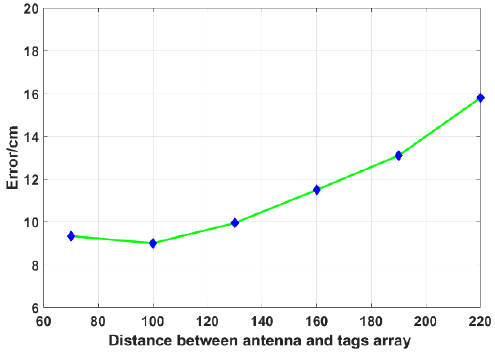
Figure 19. Distance between antenna and tags array vs. Error.